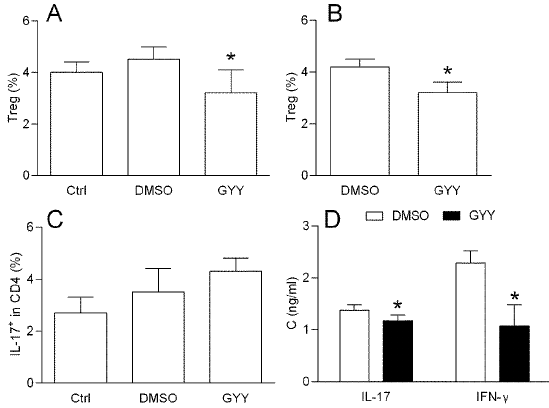
Figure 3. E ff ects of GYY4137 on the rat DLNCs. The DLNCs were isolated from the rats immunized with MOG + CFA. The percentage of CD4 + CD25 + FoxP3 + cells (Treg), and the proportion of IL17 + among the CD4 + cells were determined by cytofluorimetry. The percentage of Treg was determined among the DLNCs ( A ) or among CD4 + T cells purified from the DLNCs ( B ), after 40 min of cultivation in the presence of 200 µ M GYY4137 (GYY) or DMSO as the vehicle (DMSO). The percentage of Th17 cells was determined among the DLNCs, treated with GYY4137 (GYY) or DMSO as the vehicle (DMSO) for 40 min and subsequently stimulated for 4 h ( C ). In some experiments, the cultures without DMSO (Ctrl) were also performed ( A , C ). IL-17 and IFN- γ cytokine concentrations in the supernatants of the 24 h cell cultures of MOG re-stimulated DLNCs and treated with GYY4137, were determined by ELISA ( D ). Data are presented as the mean + standard deviation (SD) from three ( C ), four ( B ) or six samples ( A , D ). * p < 0.05 refers to